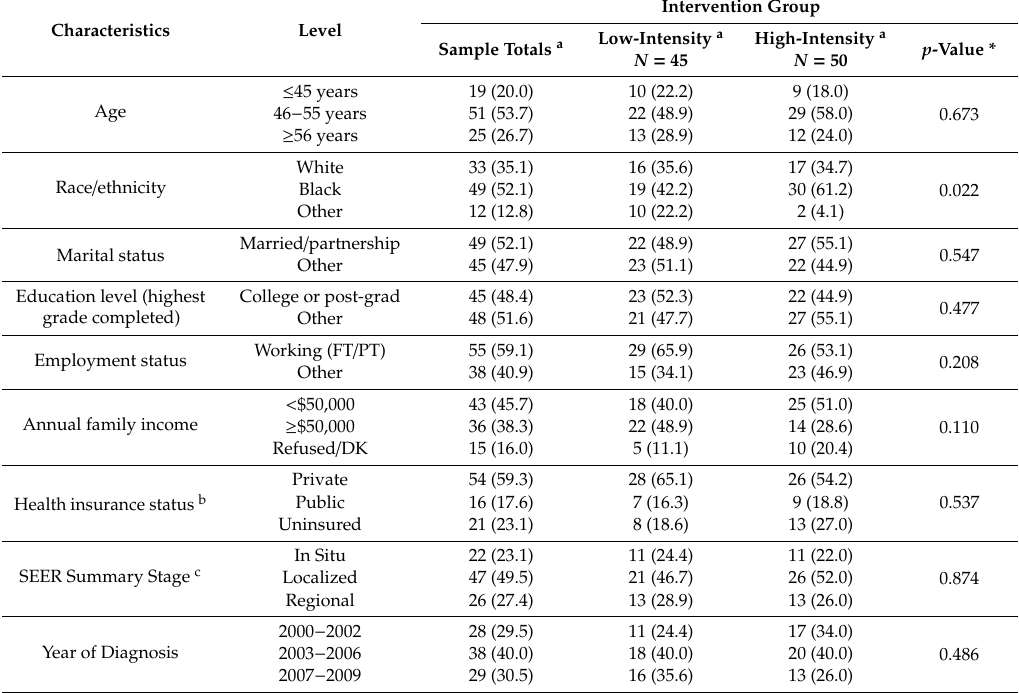
Table 1. Sociodemographic characteristics among high-risk breast cancer survivors by randomized screening intervention